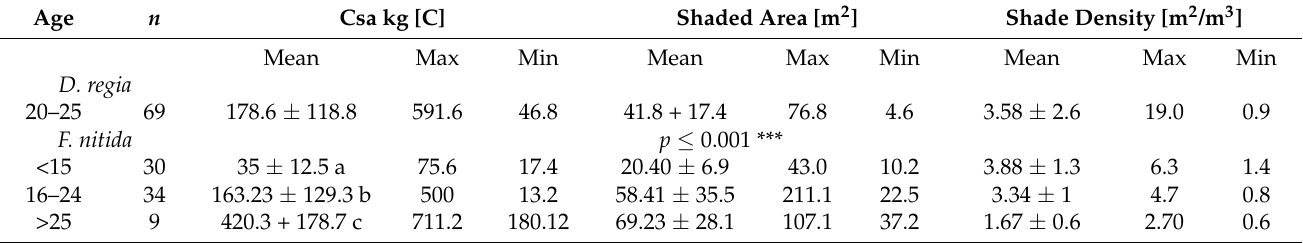
Figure 5. Ecosystem services (above-ground biomass carbon storage figure ( L ) and shading area ( R )) of D. regia , F. nitida, and P. dactylifera in the arid city of Jericho. Letters indicate the results of post hoc Tukey test. Different letters denote significant differences. Table 6. Mean, minimum, maximum, and related standard deviation as well P for p -value (with levels of significance indicated by symbols such as ***) of Csa above-ground biomass carbon storage, shaded area, and shade density for D. regia , F. nitida , and P. dactylifera for different age classes. Means within the columns differ significantly when separated by different